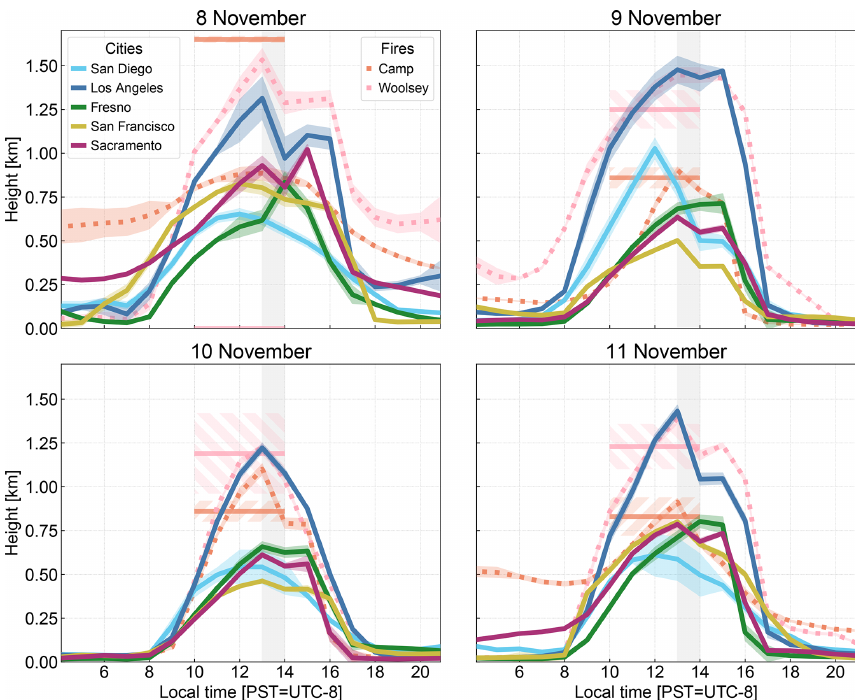
Figure 7. Diurnal variations of the boundary layer heights obtained from the ECMWF ERA5 reanalysis for major Californian cities (solid) and fires (dotted). The uncertainty estimates are based on a 10-member 4D-Var ensemble; the additional uncertainty associated with the estimation method of the boundary layer height is not shown here. Also shown are mean IS4FIRES smoke injection heights and their variation for both analysed fires as horizontal bars and hatched areas. The grey-shaded area illustrates the TROPOMI overpass time. On 8 November the injection height of the Woolsey Fire is zero because it started later in the day.